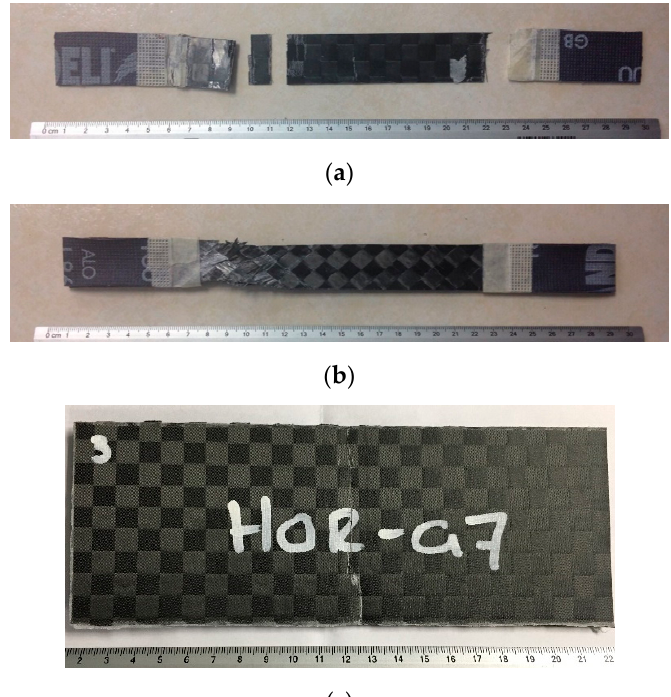
± 45] 2S and ( c ) CFRP-PVC